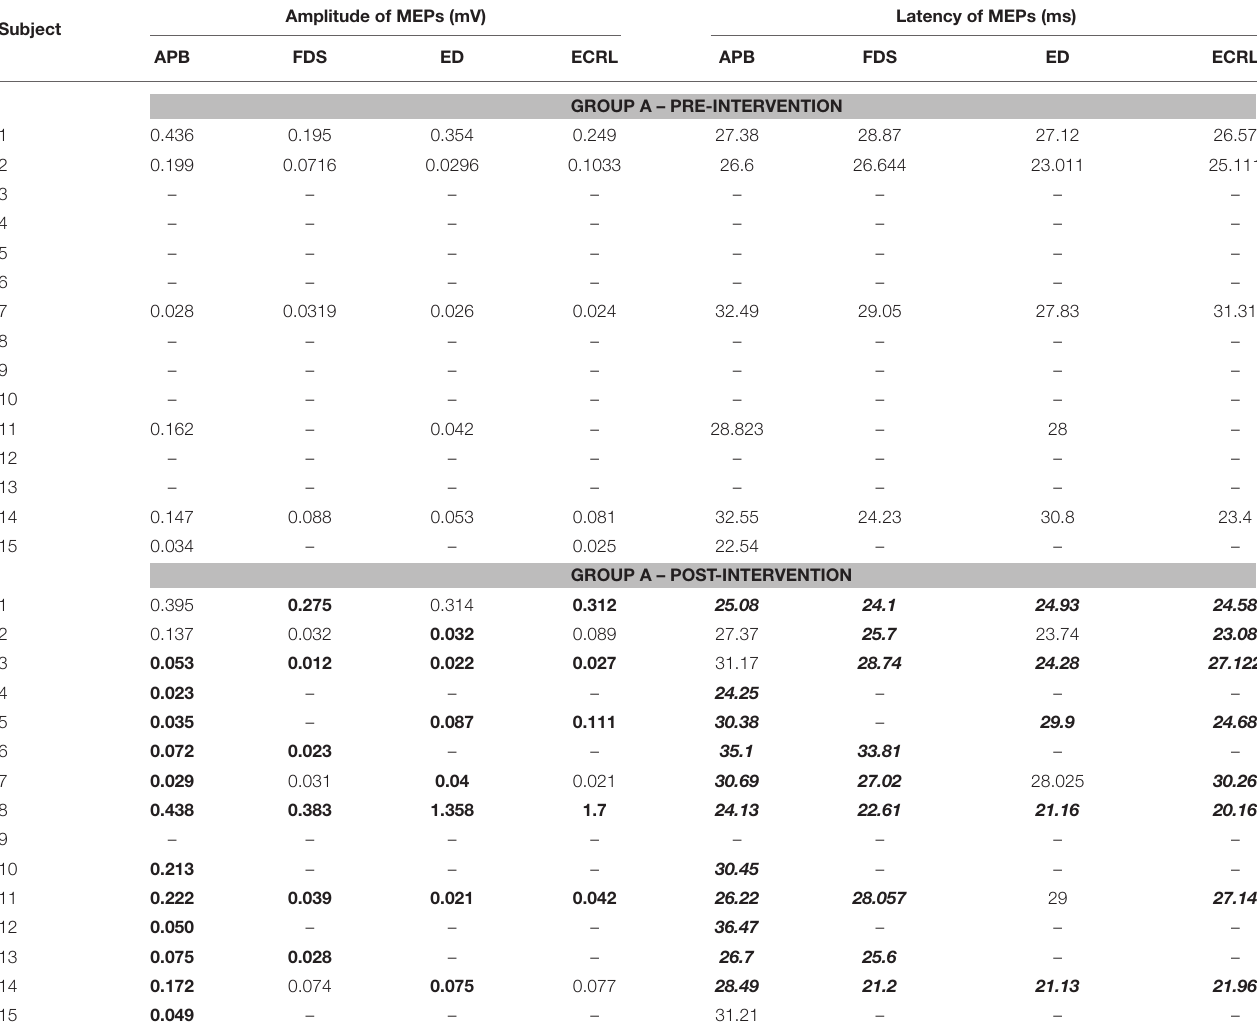
TABLE 3 | Results of Motor evoked potentials (MEPs) on the affected side in Group